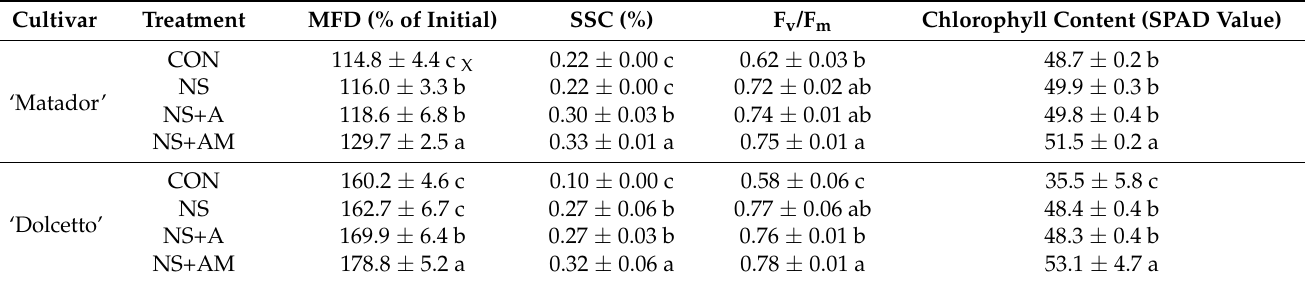
Table 2. Effect of the treatments on flower opening, soluble solids content, F v /F m ratios, and chlorophyll content of leaves of two rose